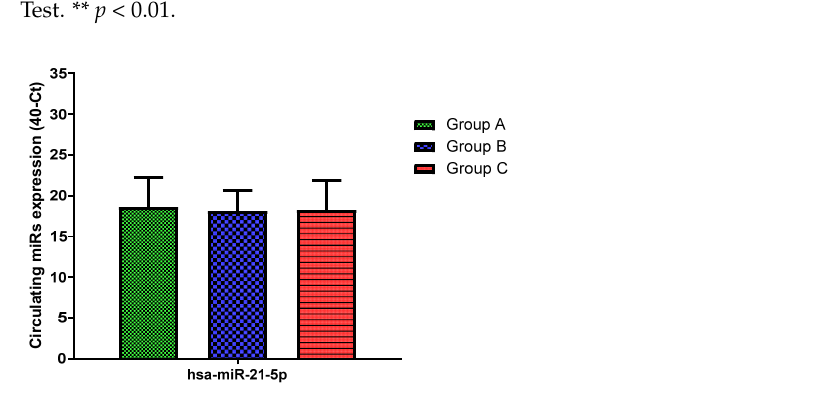
Figure 7. Serum levels of hsa-miR-21-5p in HNW (Group A), MANW (Group B) and HNAO (Group C). Results were shown as means ± SD. The statistical tests used in these analyses were one-way analysis of variance using Kruskal–Wallis test followed by Dunn’s Multiple Comparison Test.